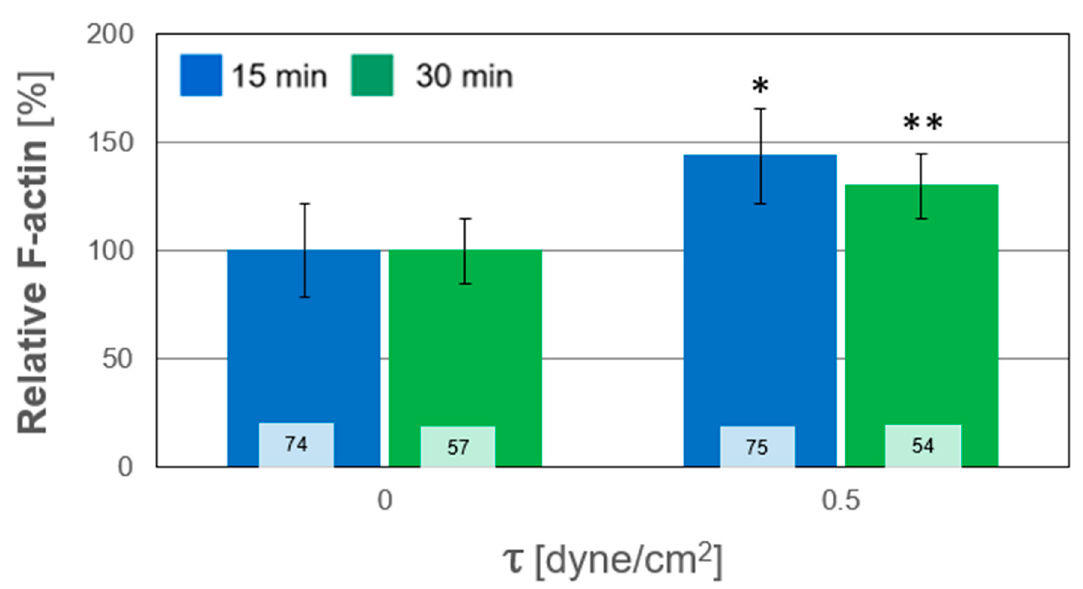
Figure 6. Combined relative alterations of cytoskeletal F-actin in cultured human conjunctival epithelial cells (HCEC) from all tests of exposure to wall shear stresses (WSS) of 0.5 dyne/cm 2 for durations of 15 min and 30 min. The data obtained after exposure to WSS were scaled by the averaged data for the unexposed controls. * and ** stand for p < 0.05, with respect to the unexposed cultures. The values inside the bars denote the number of data points calculated from the sub-regions (n).